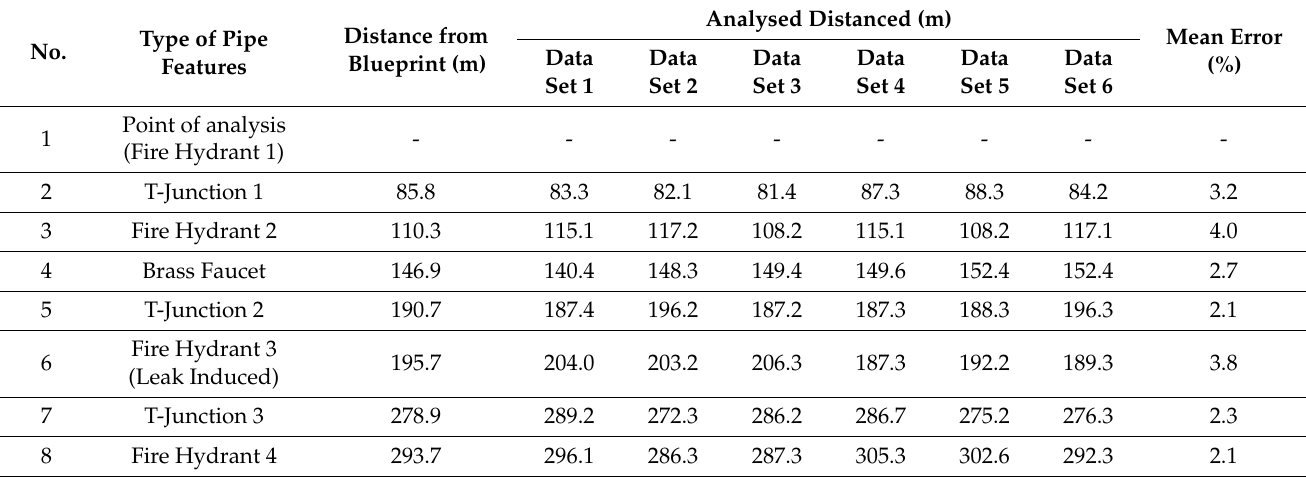
Table 6. NIKAZ evaluation for the system with 5 mm leak induced on fire hydrant 2.